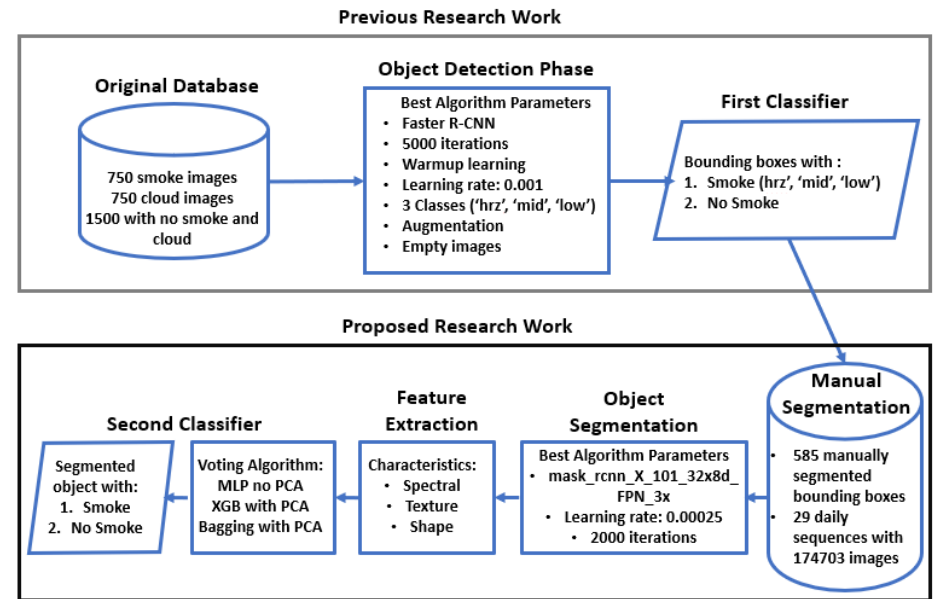
Figure 1. Workflow and overview of the best parameters of each step of the research